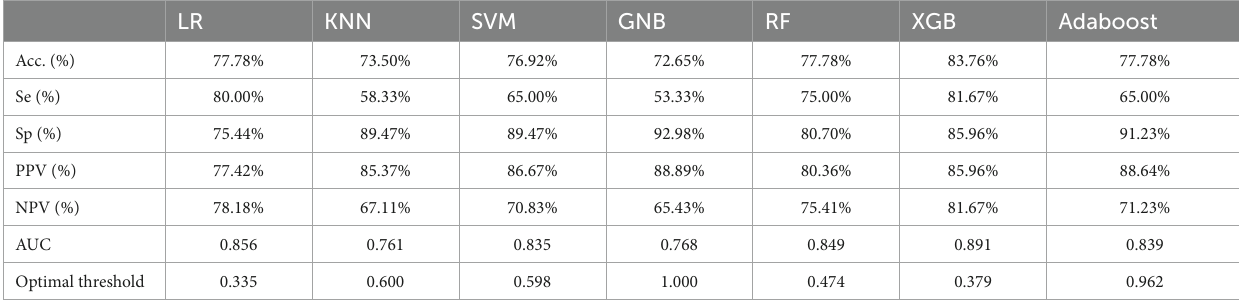
TABLE 5 Performance of classifier implementation on task